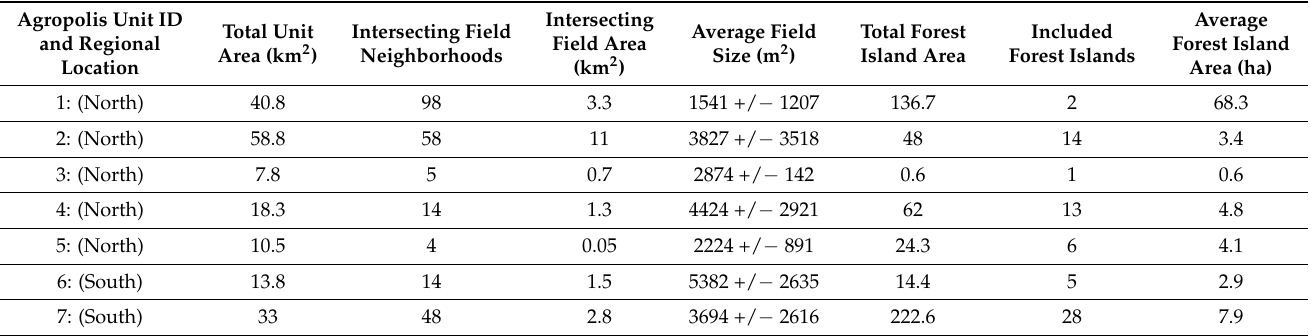
Table 6. Descriptive statistics for the seven agropolises identified (five in the north, and two in the south (see Figure 7)).